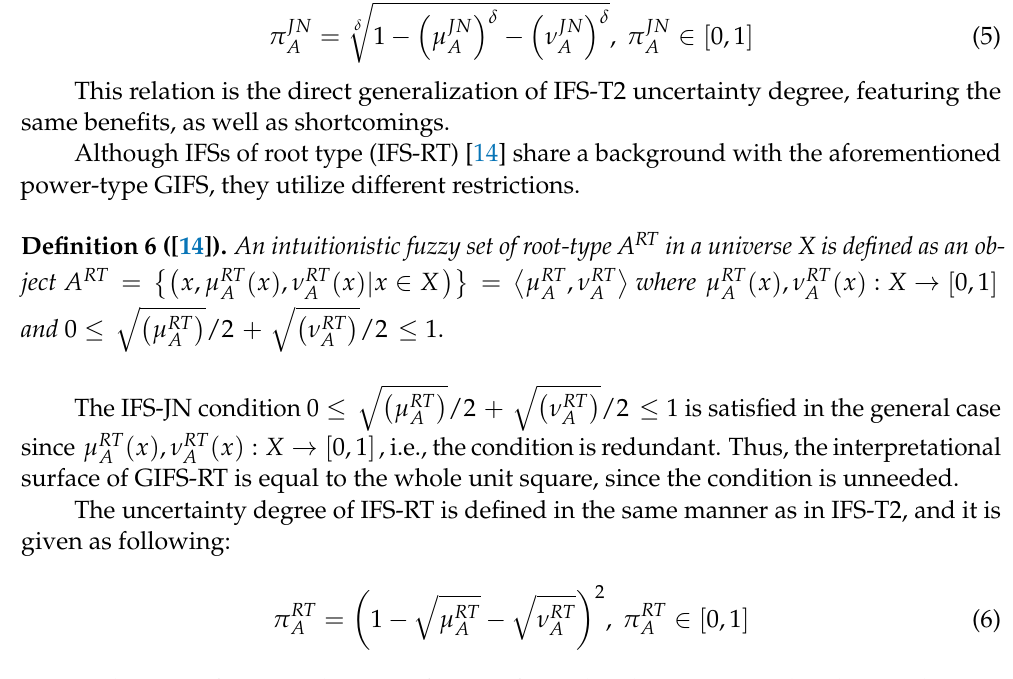
Figure 7. Liu’s generalized IFS offers the greatest descriptive power for L = 1, transforming GFIS-L-interpretational surface to the unit